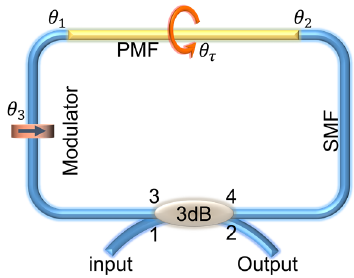
Figure 1. Schematic diagram of the Sagnac interferometer.